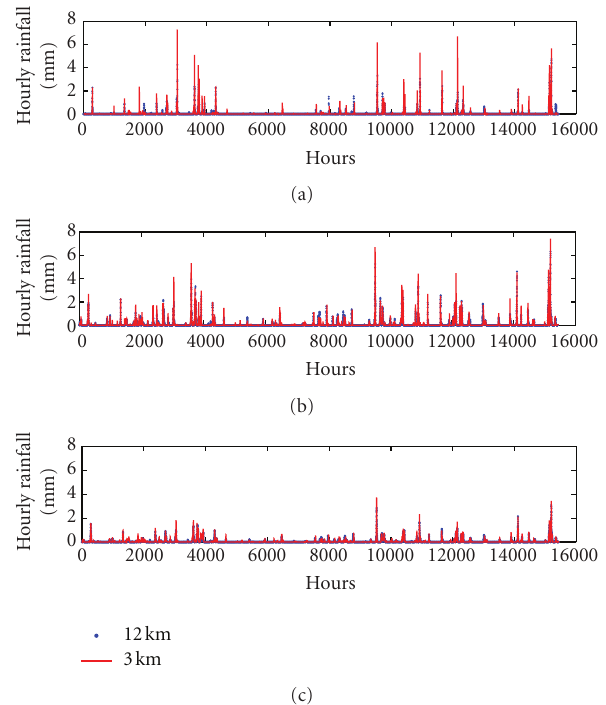
Figure 8: Time series of hourly rainfall averaged over (a) box (i), (b) box (ii) in Figure 2(a), and (c) the entire innermost domain (Arizona). The red line and blue dots are for the 3km and 12km runs, respectively. Each panel contains the time series for all 7 winters stitched together. Abscissa is time in hours.